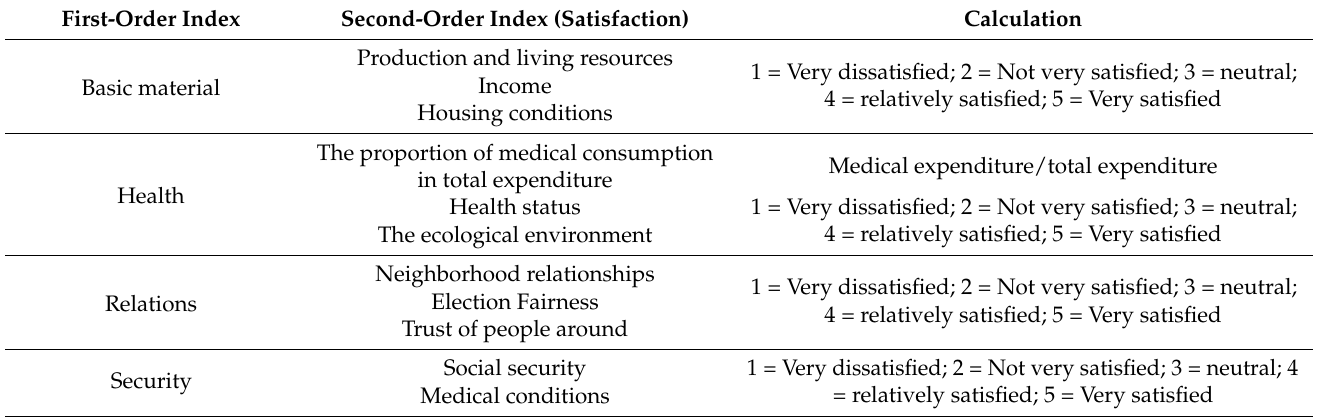
Table 2. The evaluation index system of